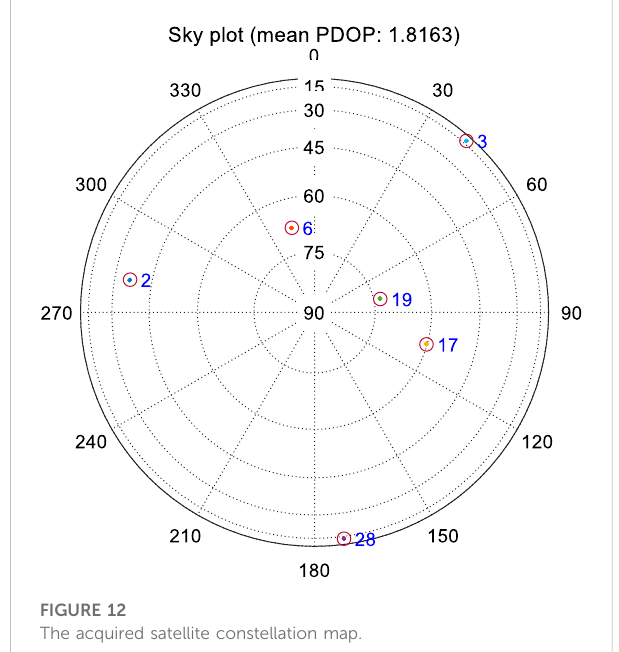
FIGURE 12 The acquired satellite constellation